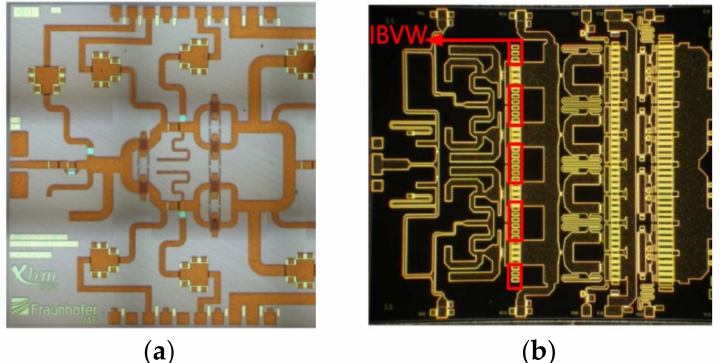
Figure 16. ( a ) The 2-stage PA in 100 nm GaAs HEMT [80]. ( b ) Combining PA with IBVW in 100 nm GaAs pHEMT [82].